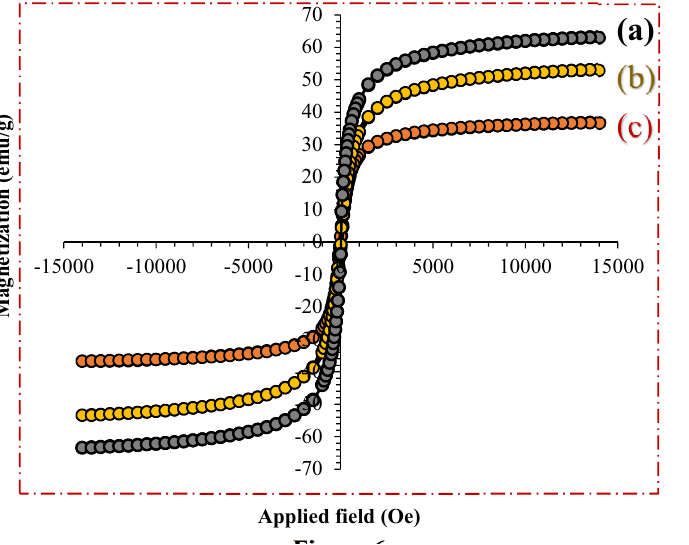
Figure 6. The magnetic properties of ( a ) Fe 3 O 4 ( b ) Fe 3 O 4 @Pectin ( c ) Fe 3 O 4 @Pectin@(CH 2 ) 3 -Acetamide-Cu(II).